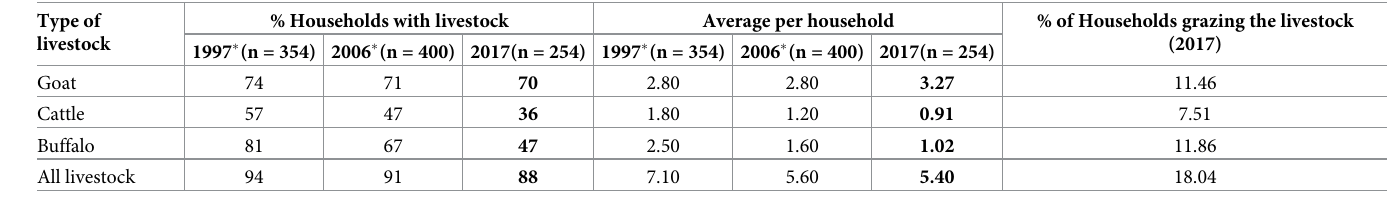
Table 3. Percentage of households with livestock, average livestock ownership per household and percentage of households grazing their livestock. Data for 1997 and 2006 obtained from Gurung et al. (2010). Type of % Households with livestock Average per household % of Households grazing the livestock livestock